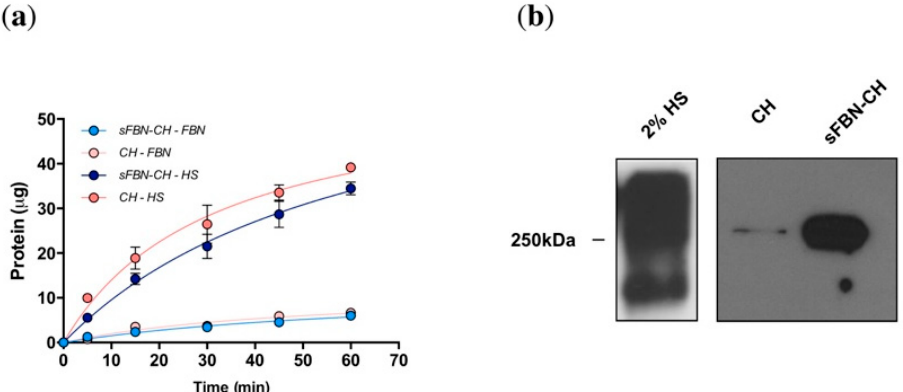
Figure 2. Protein adsorption over time and aptamer-doped chitosan selectivity for FBN. ( a ) Time-course of serum proteins and of pure FBN deposition on CH and sFBN-CH samples. ( b ) Western blot analysis of FBN stably adsorbed on CH and on sFBN-CH.